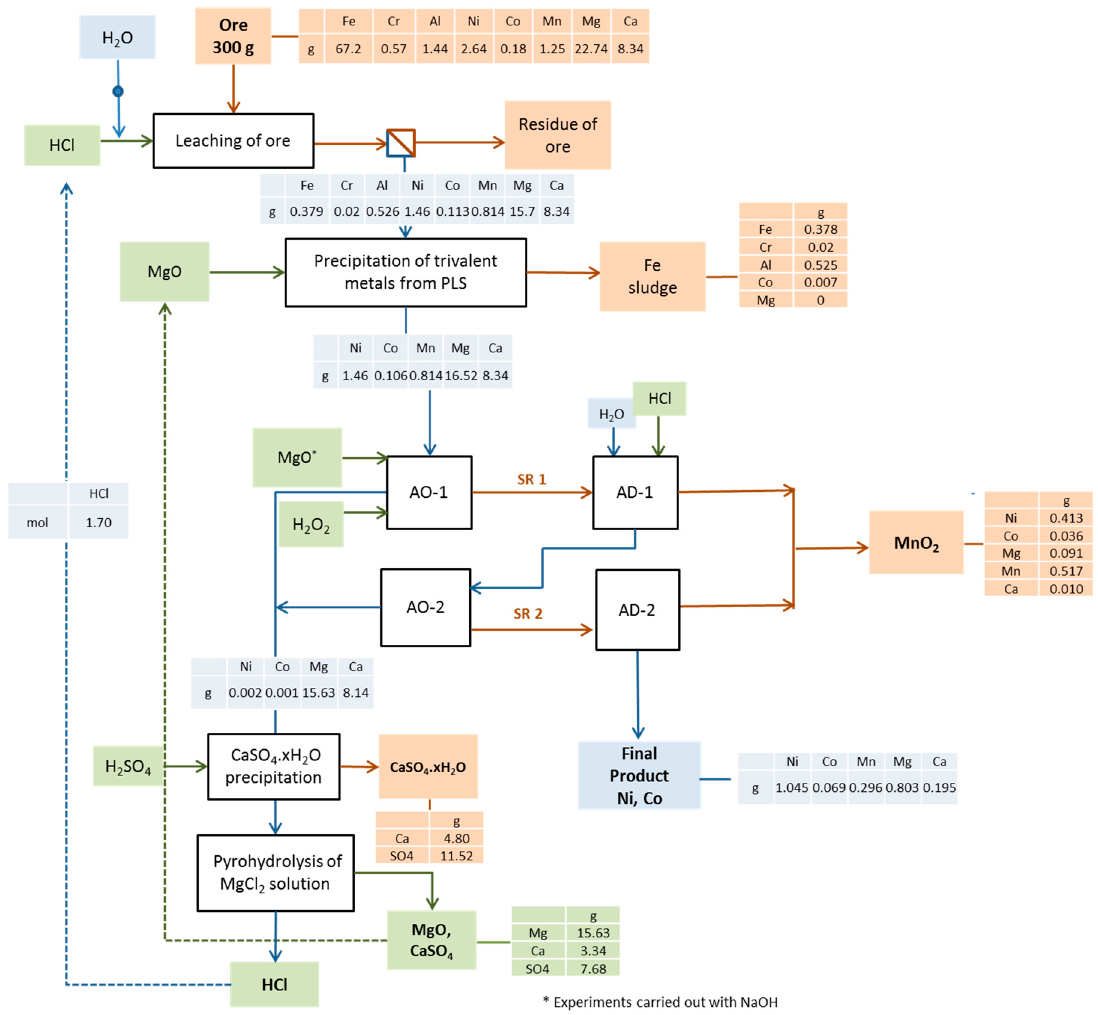
Figure 13. Flowchart simulating CCL operation at 30% pulp density, including mass balance of metals.